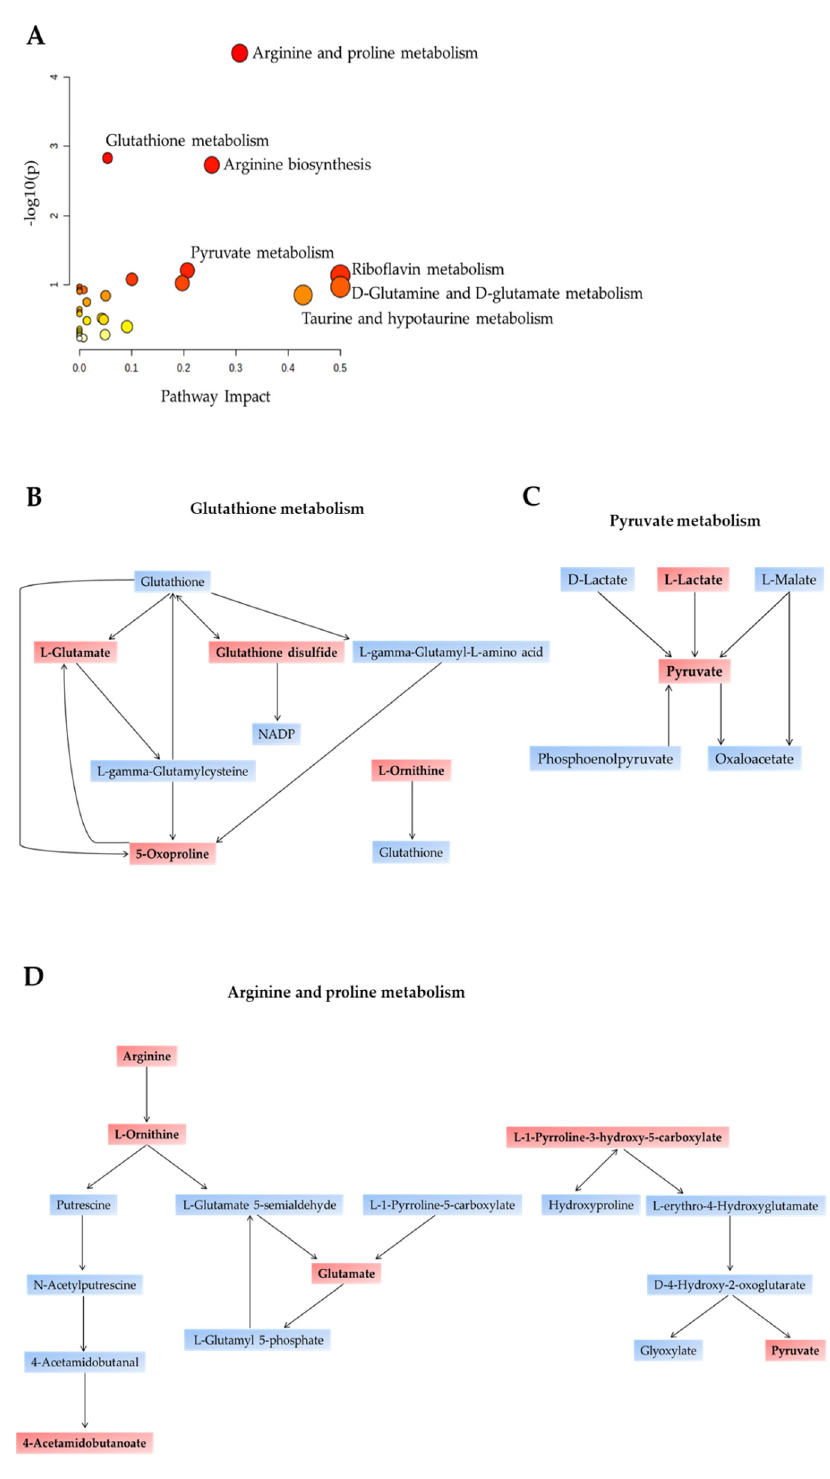
Figure 4. Primary affected metabolic pathways identified in SVHF serum samples. ( A ) The x -axis and size of circles represent impact of differential metabolites within the pathway. The y -axis and color of circles represent statistical significance of the overall metabolic changes within the pathway. ( B – D ) Schematic representation of the top three dysregulated pathways between BVNF and SVHF serum samples. ( B ) Glutathione metabolism pathway. ( C ) Pyruvate metabolic pathway. ( D ) Arginine and proline metabolic pathway. Metabolites mentioned in red boxes are among the 34 metabolites differentially expressed between BVNF and SVNF serum samples.